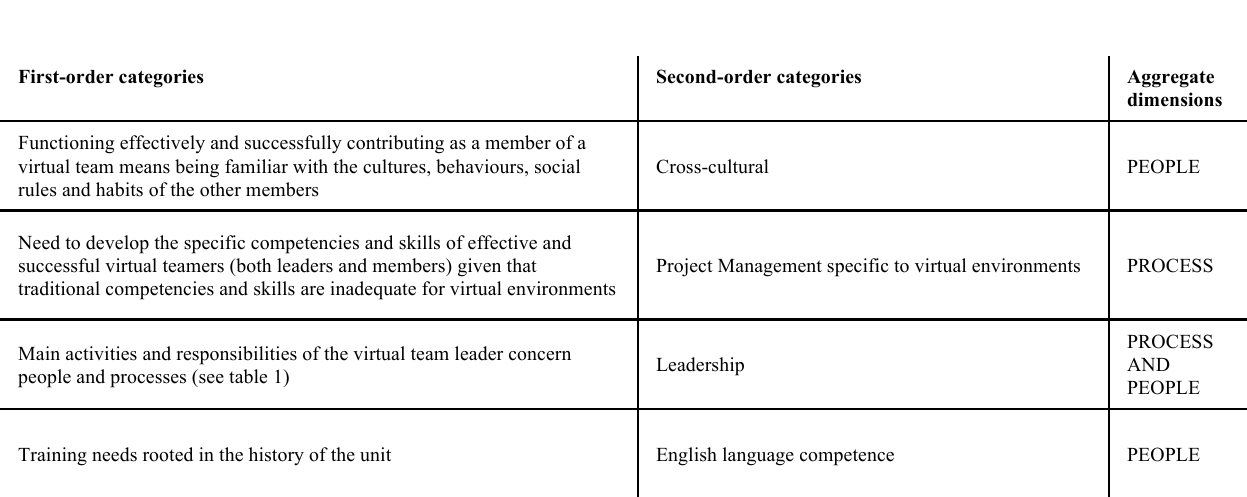
Table 1. Perceived key factors influencing the efficacy of virtual teams